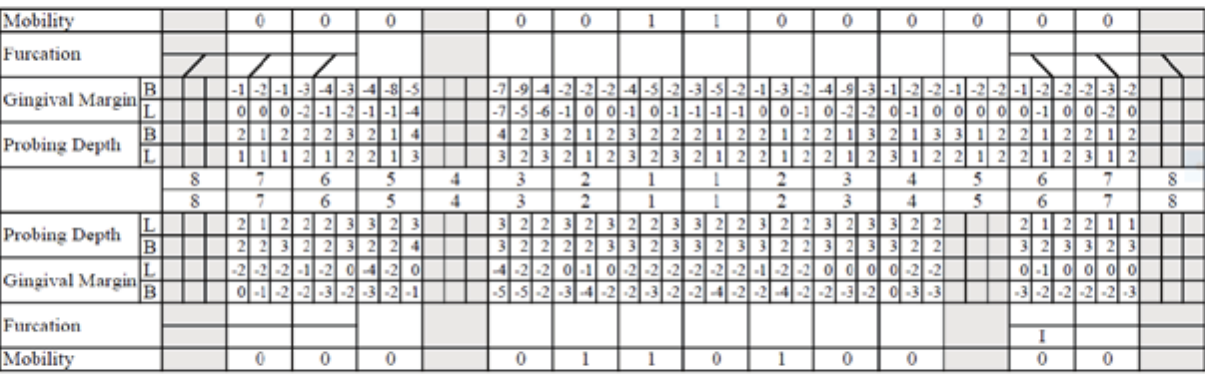
Figure 2. Pretreatment periodontal